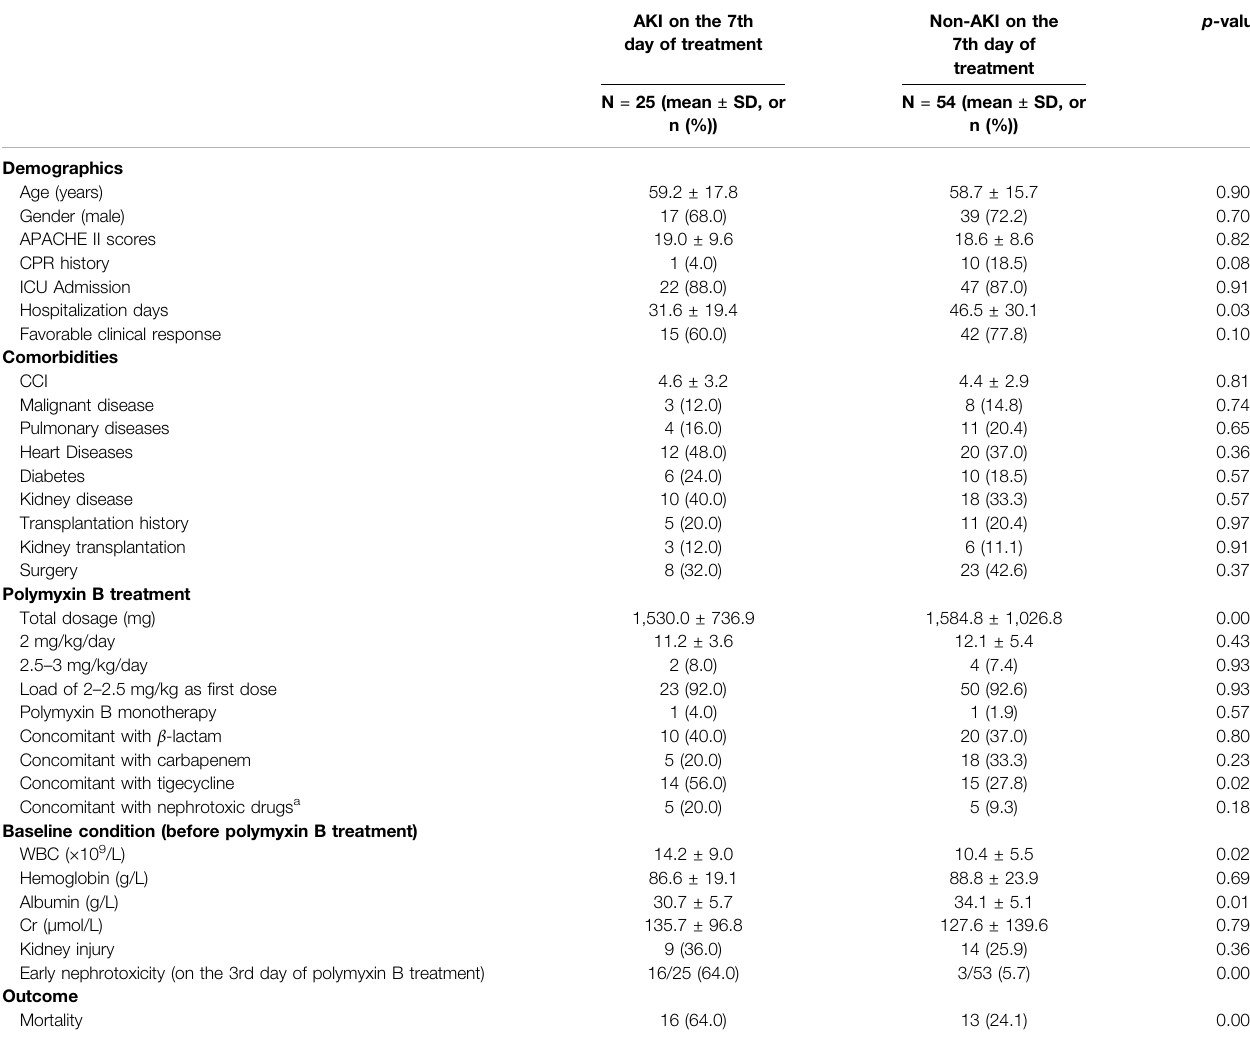
TABLE 3 | Univariate analysis for late nephrotoxicity.